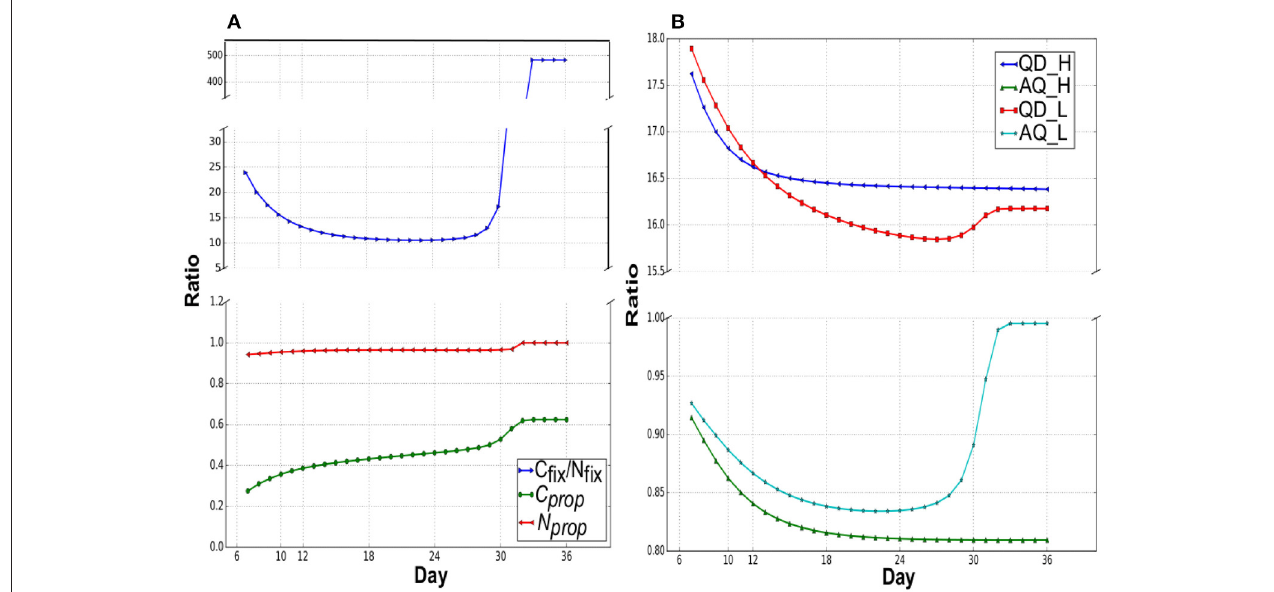
FIGURE 3 | (A) Assimilation and partitioning of carbon and nitrogen under N low . C prop , and N prop are the proportions of C and N allocated to root and leaf, respectively in a day from the total uptake. Remaining C and N were allocated to leaf and root, respectively. C fix /N fix is the ratio of net carbon fixed during the light (flux of CO 2 transport into leaf during the light phase, CO2_tx_Leaf_Day) to the nitrate uptake in a day (light + dark). (B) Quantum demand (QD) and assimilation quotient (AQ) under N low and N high . QD is the ratio of photon required:net CO 2 fixed (Photon_tx_Leaf_Day:CO2_tx_Leaf_Day i.e., σ P: σ CO 2 ) and AQ is the net CO 2 fixed:net O 2 released